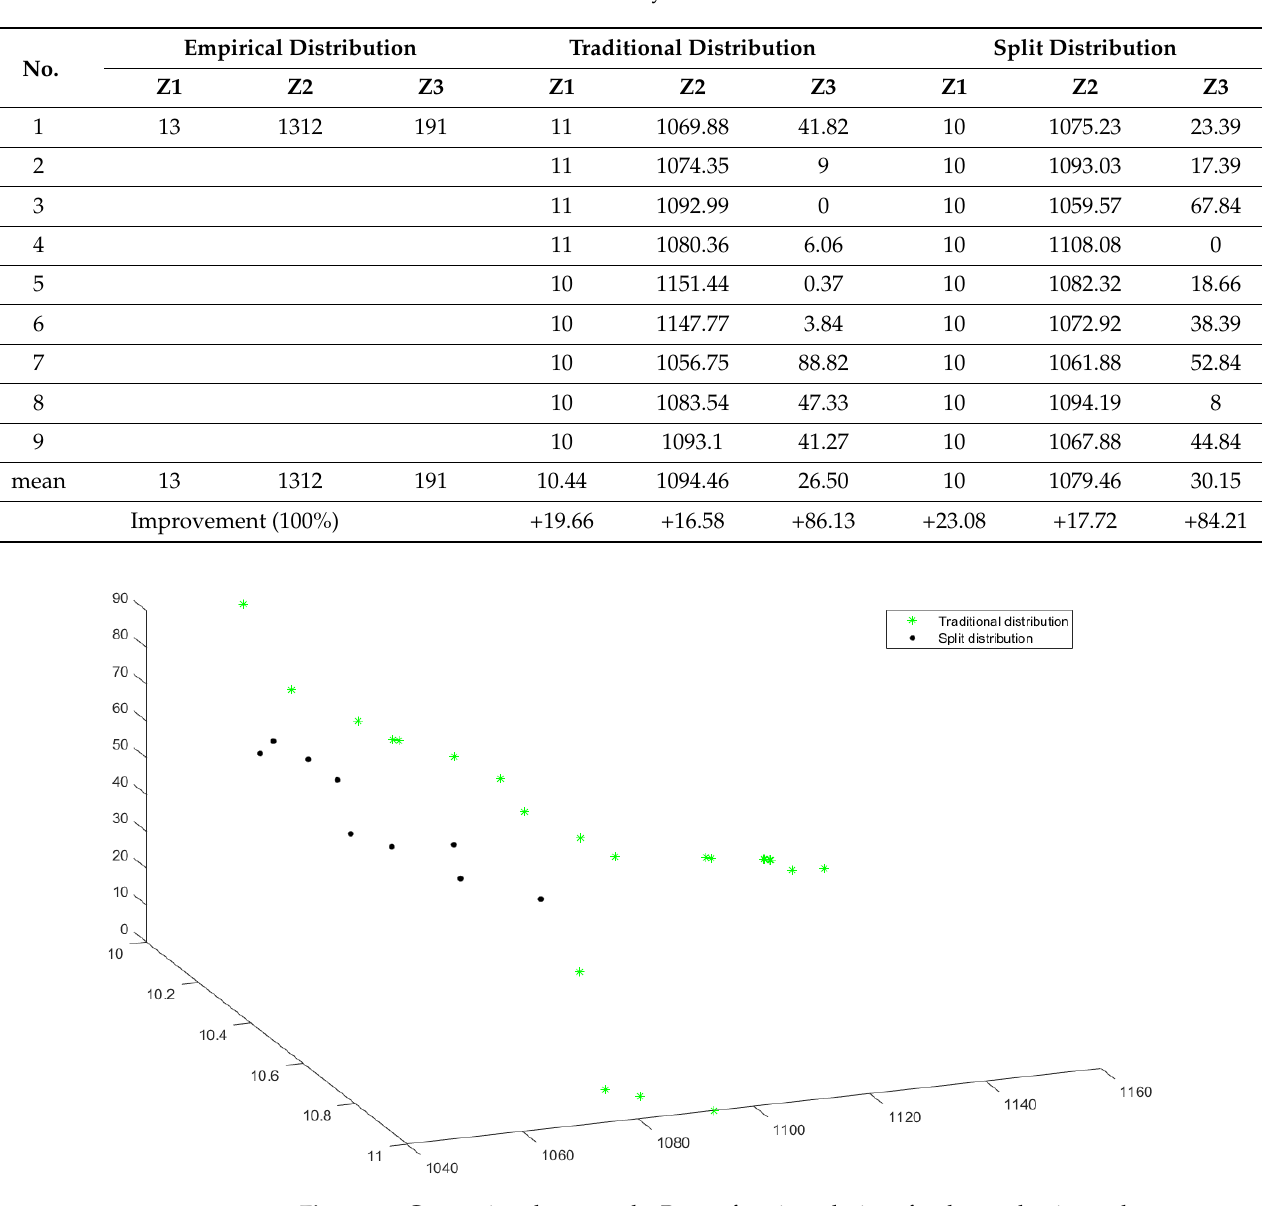
Table 9. The best result of case study.